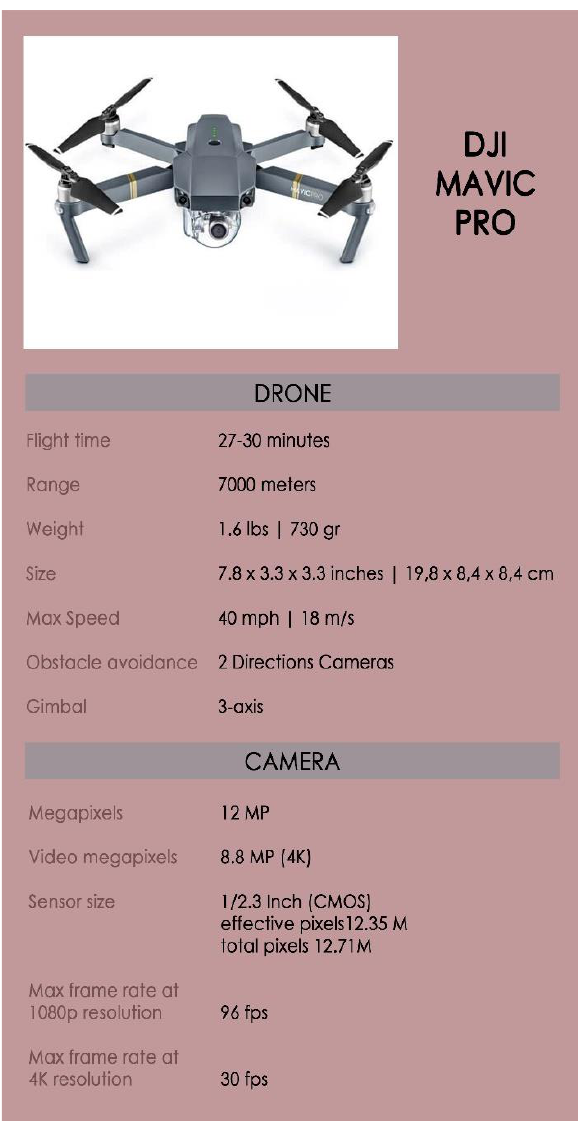
Figure 14. DJI Mavic Pro - specifications.